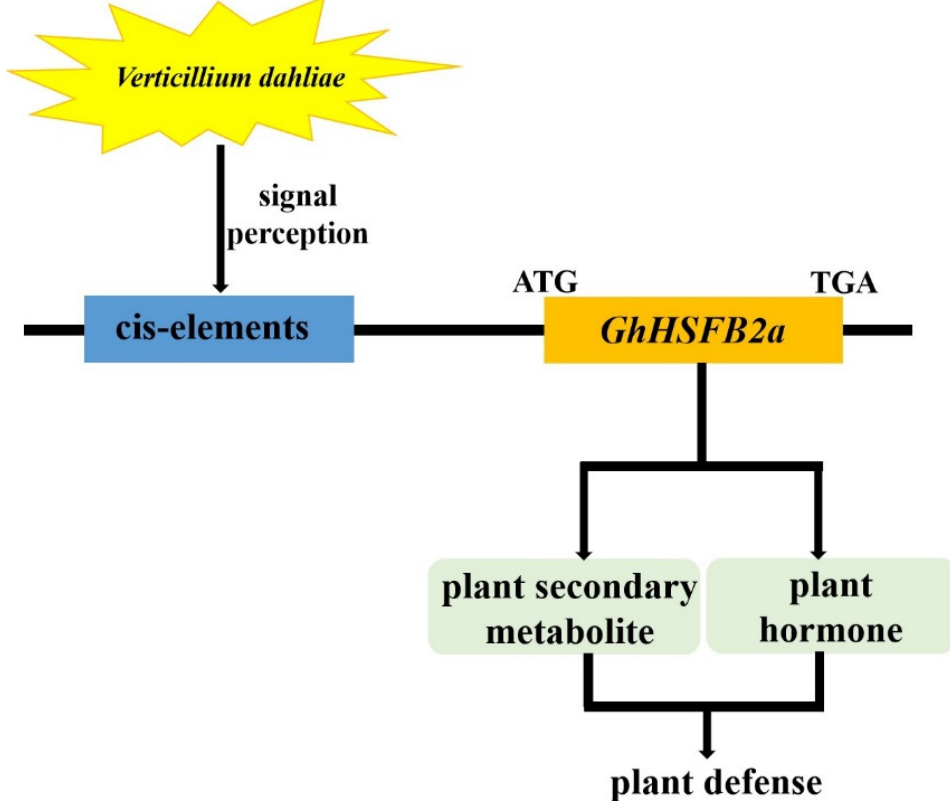
Figure 10. Model for GhHSFB2a function in cotton. GhHSFB2a regulated plant defense by affecting plant phytohormones (ethylene, ABA) and secondary metabolic (linoleic acid, phenylpropanoids).